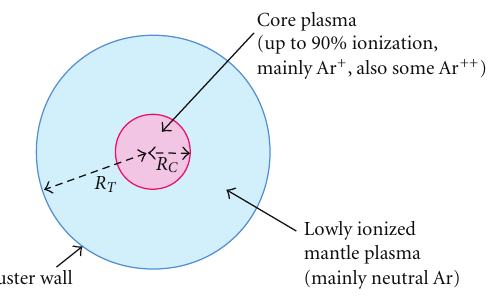
Figure 1: Vertical section of the thruster source cylinder.